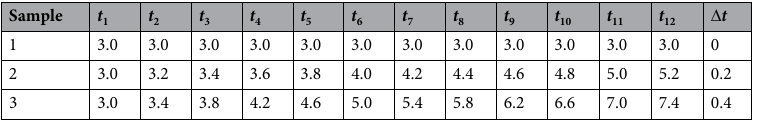
Table 1. Ferrite rod thicknesses t n of the proposed